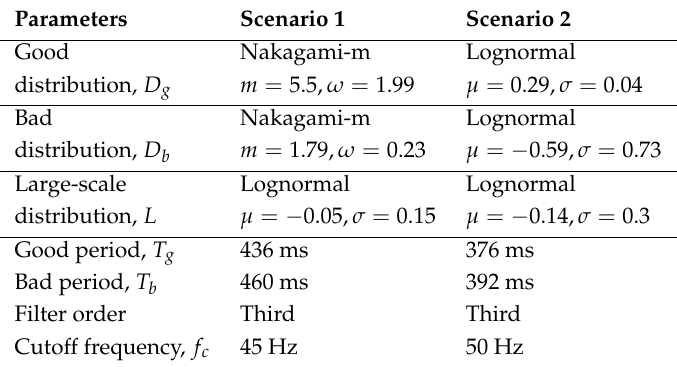
Table 3. Parameters used for simulation of cycling